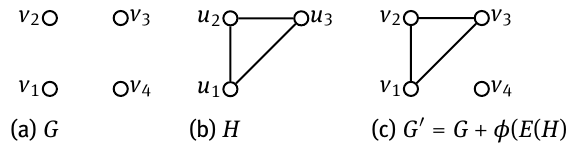
Figure 4: (a) Graph G , the empty graph on four vertices. (b) Graph H , the complete graph on three vertices. (c) Graph G (cid:48) which is the graph G with H glued into G with respect to ϕ